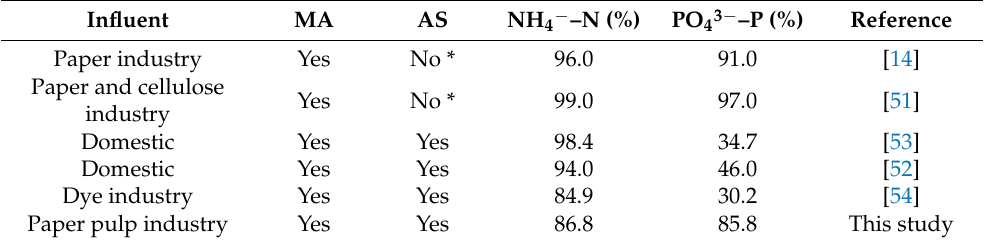
Table 2. Comparison of NH 4 − –N and PO 43 − –P removal efficiencies in photobioreactors with various types of